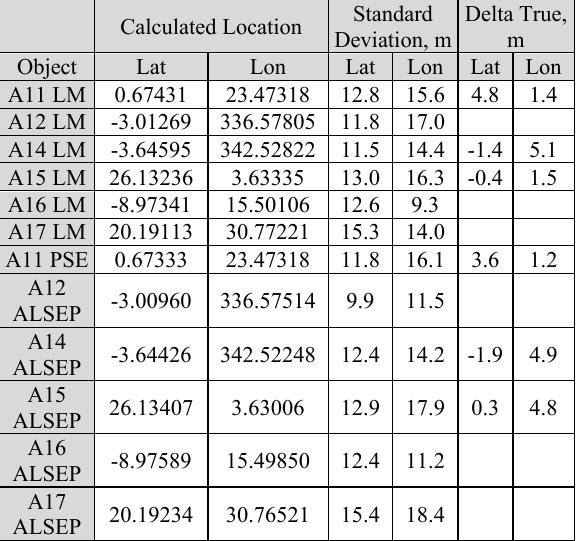
Table 3. Location of Apollo surface hardware derived from NAC images using the improved pointing correction